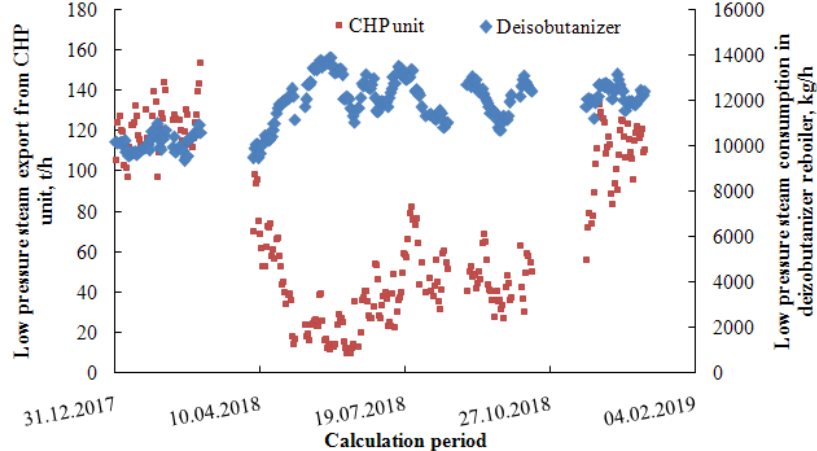
Figure 9. Overview of low pressure steam export from the CHP unit and its consumption in the deisobutanizer reboiler during the calculation period.